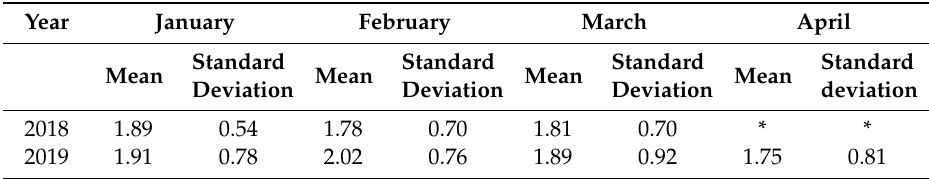
Table 4. Monthly mean and standard deviation of the wind magnitude (m s − 1 ) for the months of lowest discharge at the weather station located in Niebla (Figure 1, green